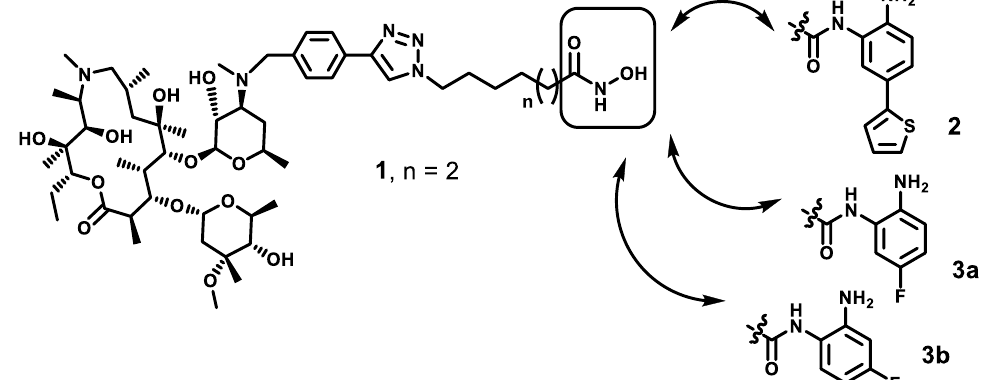
Figure 2. Design of class I selective macrolide-based HDACi 2 and 3a , b based on the swapping of hydrozamate moiety of 1 for class I selective ZBGs.